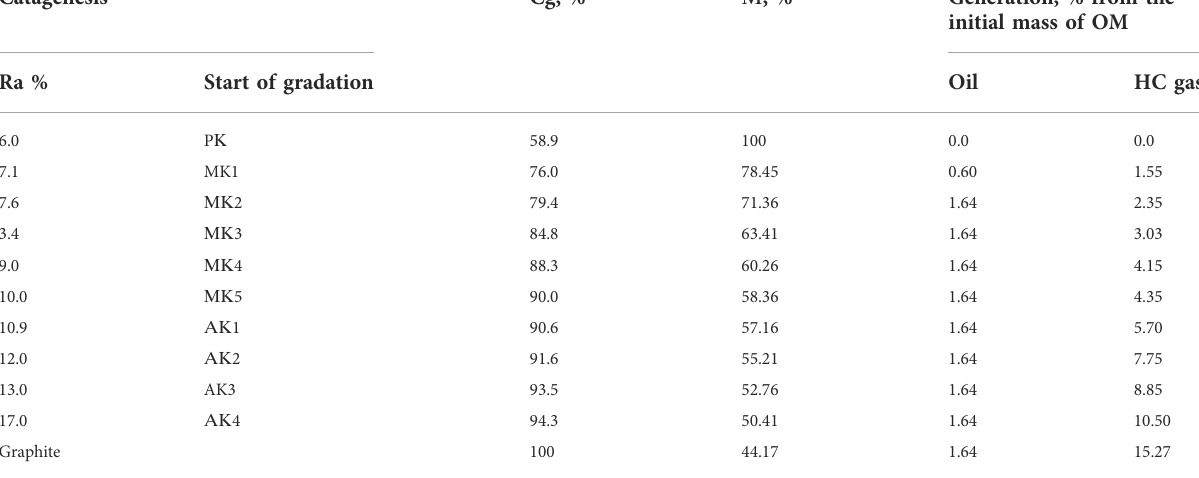
TABLE 4 Generation of oil, hydrocarbon gas, and other volatile products by humic OM for recalculation at the beginning of catagenesis (Neruchev and Smirnov, 2007). Catagenesis Cg, % N , % Generation, % from the